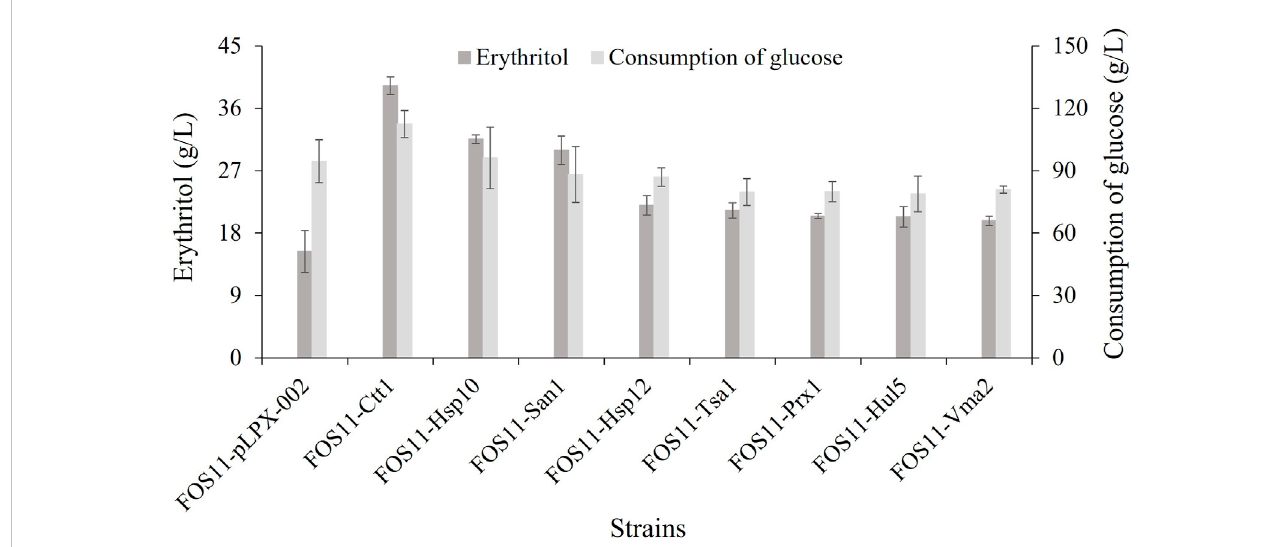
FIGURE 3 Theproductionoferythritolandtheconsumptionofglucoseofcontrolandengineeredstrainsat35 ° C.Datarepresentthemean±SDofthreebiological replicates.